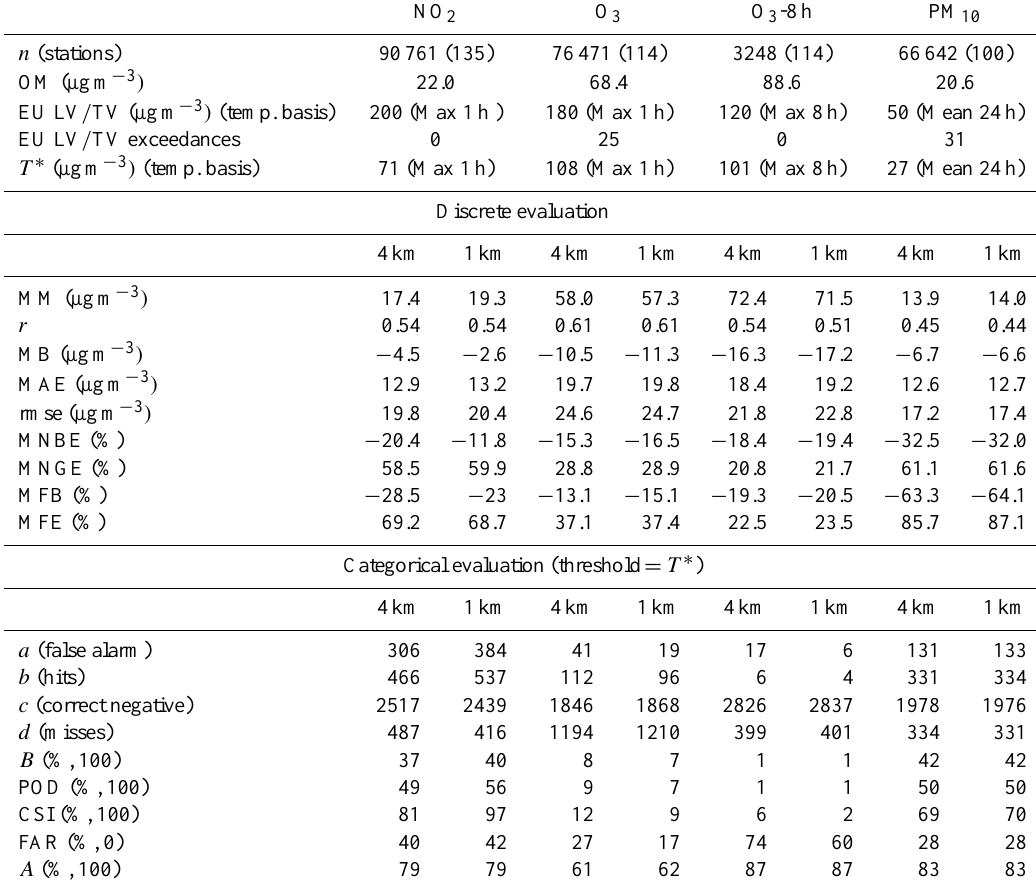
Table 2. Discrete and categorical statistics for NO 2 , O 3 , O 3 -8h, and PM 10 for April 2013 as functions of horizontal resolution (4 and 1km). n indicates the number of pairs of data used in the discrete evaluation on an hourly basis. OM and MM depict the measured and modeled mean concentrations, respectively. T is the threshold applied in the categorical evaluation. Max 1h and mean 24h concentrations are calculated by considering more than 75% of the hours in a day, as established by Directive